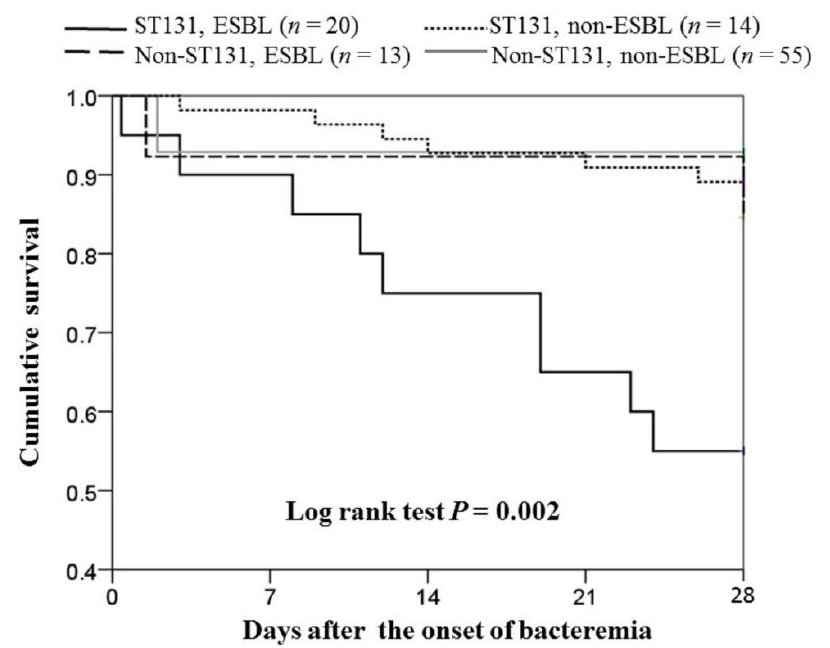
Figure 4. Survival curves of the cases of community-onset ST131 and non-ST131 Escherichia coli bacteremia empirically treated by an inappropriate antibiotic, categorized by the presence or absence of ESBL production.